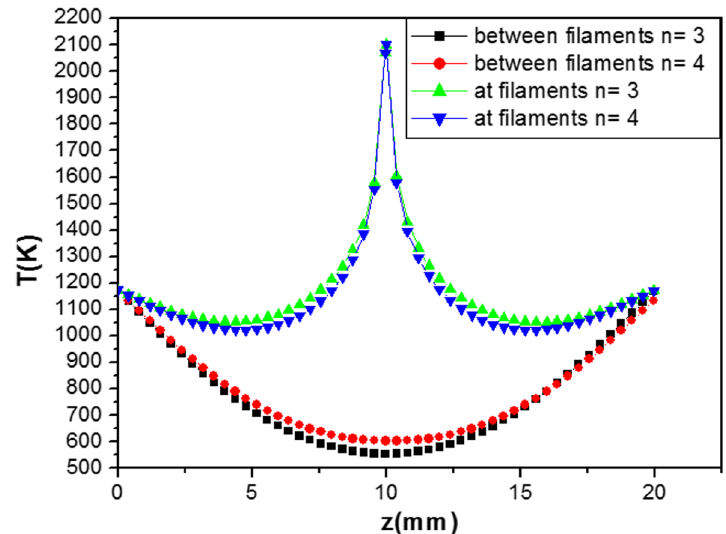
Fig. 2 Distribution of T as a function of z between filaments and at the filaments for n